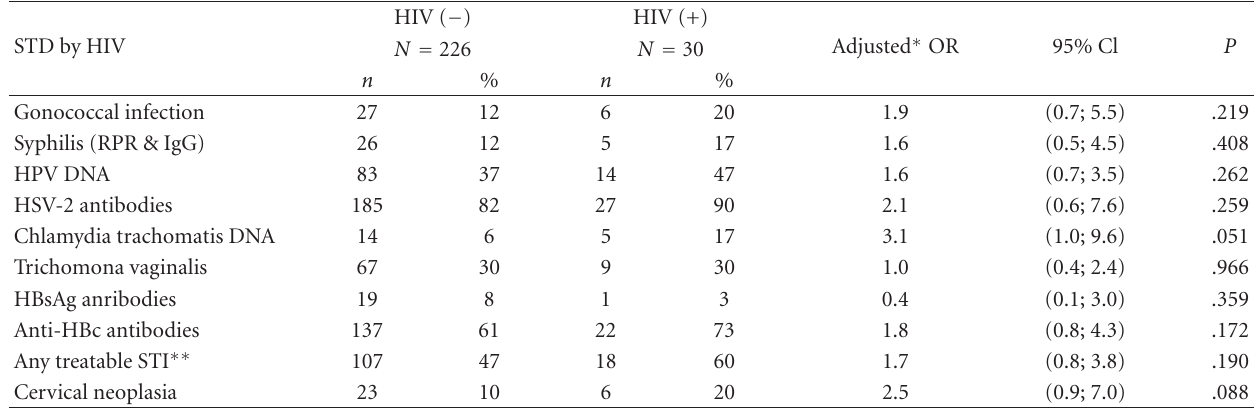
Table 4: Prevalence and risk of STIs and cervical neoplasia by HIV